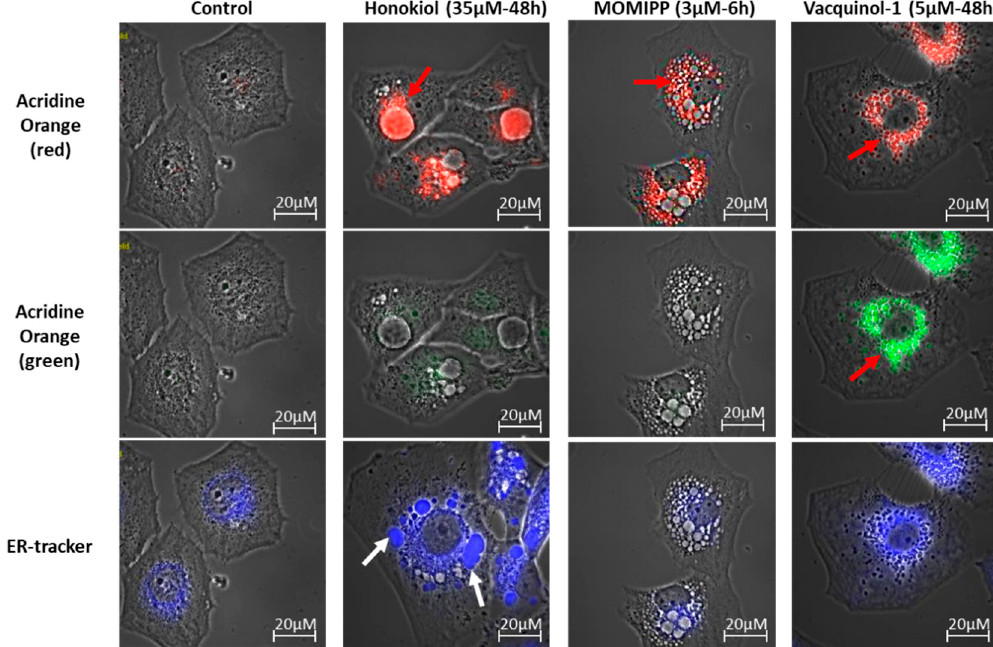
Figure 8. Illustration of the fluorescent characterization of the vacuoles using different fluorescent cell compartment trackers in U373 cells. Two kinds of vacuoles can be observed after treatment with honokiol: red arrows show acridine orange positive vacuoles possibly derived from macropinocytosis, and white arrows show ER-positive vacuoles. Some vacuoles induced by MOMIPP are red-positive with acridine orange (red arrow) but none to the ER-tracker. Vacquinol-1-induced vacuoles are red-positive (red arrow), but also green-positive stained by acridine orange. This experiment has been conducted three times in